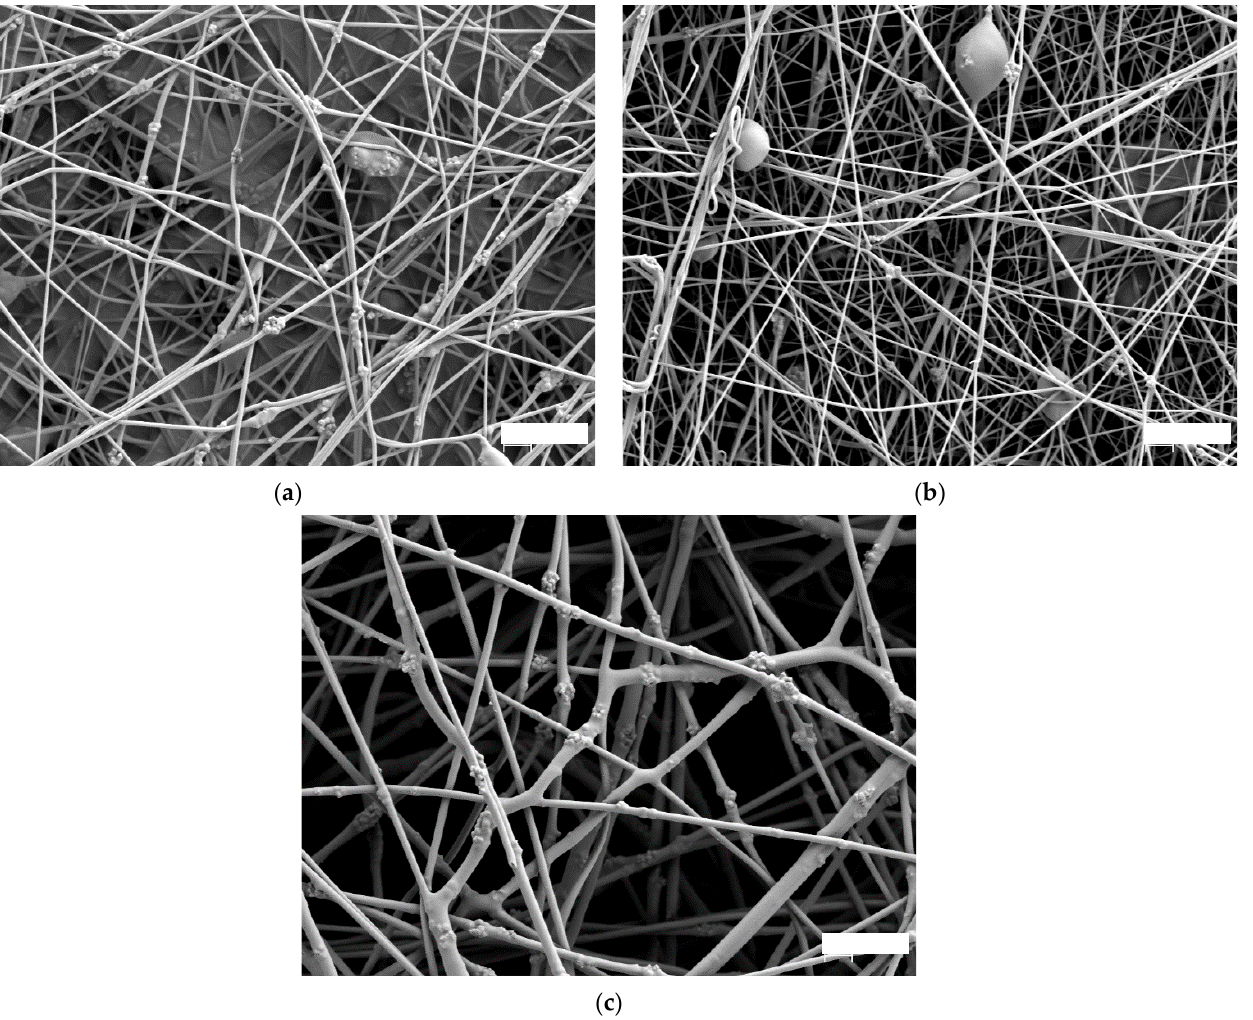
Figure 5. Scanning electron microscope (SEM) micrographs of the magnetic nanofiber mats: ( a ) 16 wt% PAN with 65 kV voltage and 40 min ultrasonic bath; ( b ) 16 wt% PAN with 80 kV voltage and 40 min ultrasonic bath; ( c ) 16 wt% PAN and 80 kV voltage without ultrasonic bath. Scale bars indicate 3 μ m.